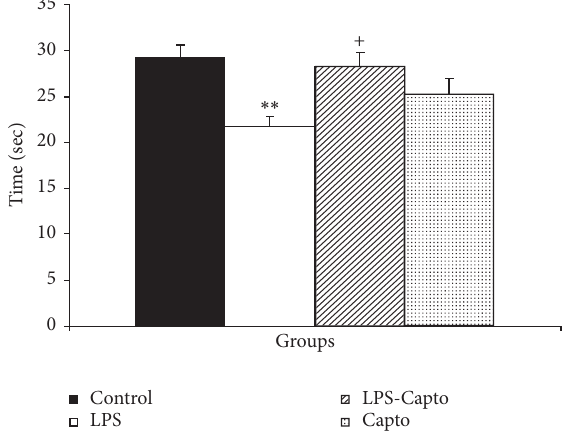
Figure 4: The results of the time spent in the target quadrant (Q1) in probe day, 24 hours after the last learning session. The platform was removed and the time spent in the target quadrant was compared between the groups. Data are shown as mean ± SEM ( 𝑛 = 10 in each group). ∗∗ 𝑃 < 0.01 compared with the control group and + 𝑃 < 0.01 compared with the LPS group.